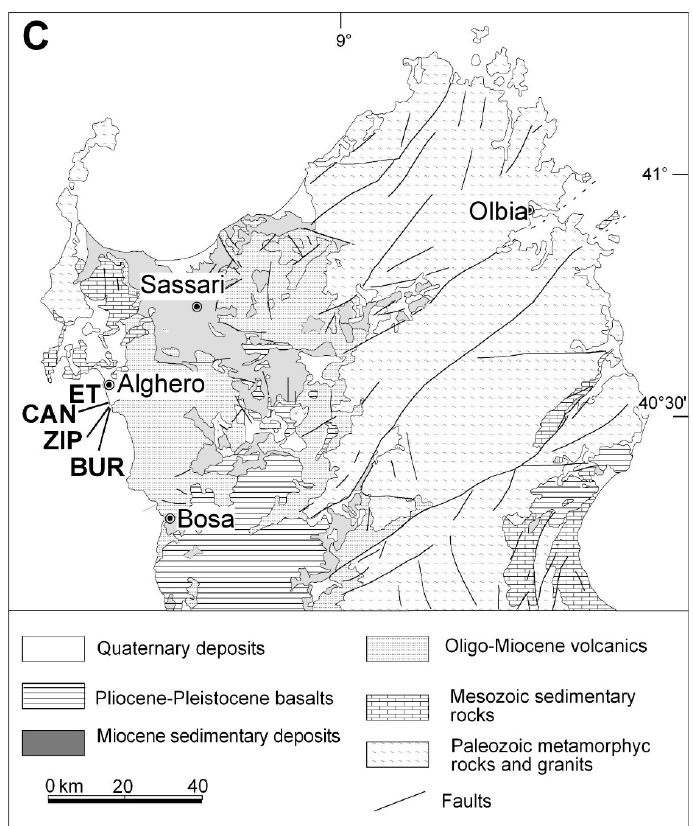
Figure 3. Schematic geological map of Sardinia (modified from [27]). Geosciences 2019 , 9 , x FOR PEER REVIEW